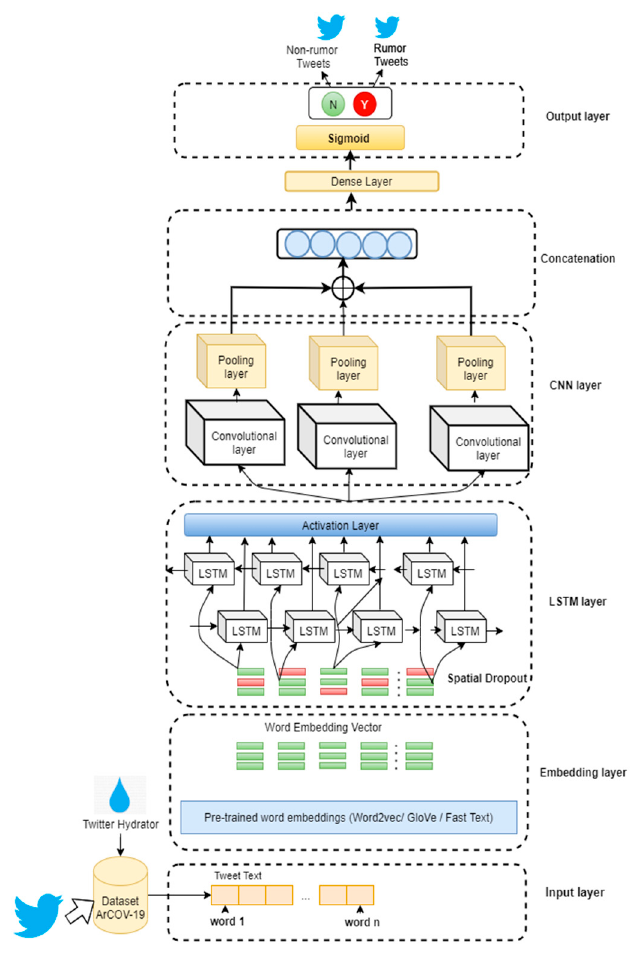
Figure 3 . Structure of the LSTM–PCNN model . Figure 3. Structure of the LSTM–PCNN